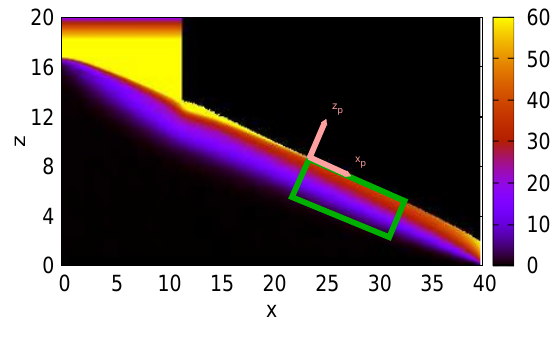
Figure 2. Spatial distribution of magnitudes of velocity for mass flow rate of 88.3 g / s. Colour scale for the distribution is provided on the right hand side. The green box indicates the region of analysis.The transformed co-ordinates are also shown. Qualita- tively similar distributions are obtained for the other flow rates also.